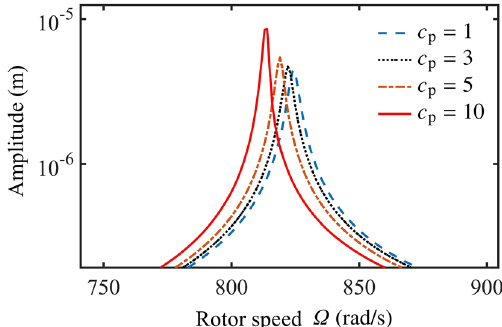
Figure 8 Comparison of time history, whirling orbits, and frequency spectrum for λ ( b ) Whirl orbits, ( c ) Frequency